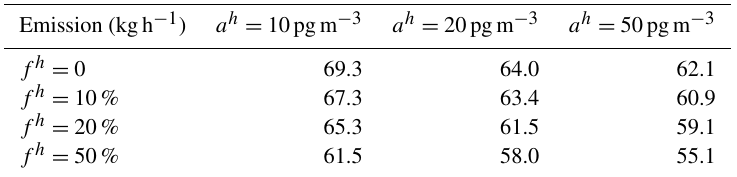
Table 7. Emission strength of release 2 that minimizes normalized F defined in Eq. (5) for different f h and a h . Logarithm concentration is taken as the metric variable. ((cid:15) ln (c)